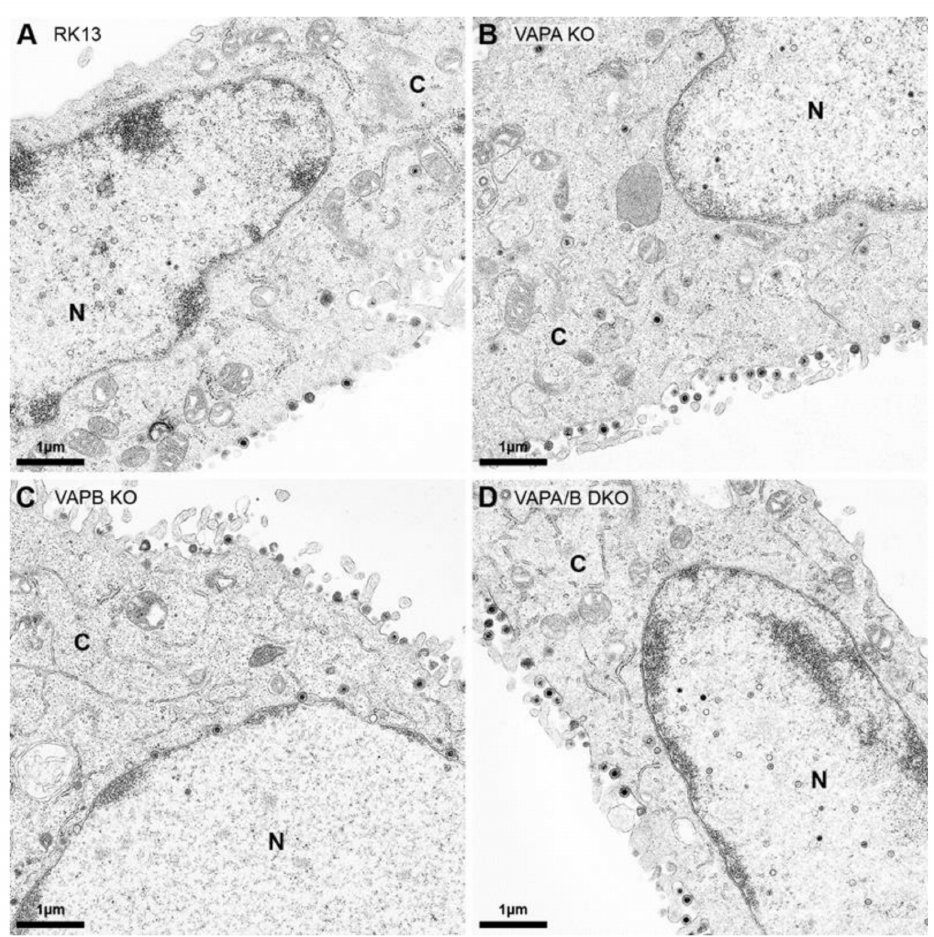
Figure 5. Ultrastructural analysis of PrV-Ka infected RK13, VAP KO and DKO cells. ( A ) RK13, ( B ) RK13-VAPA KO, ( C ) RK13-VAPB KO and ( D ) RK13-VAPA/B DKO cells were infected with PrV-Ka (MOI 1) and processed for electron microscopy 14 h post infection. Shown are presentative images. N: nucleus, C: